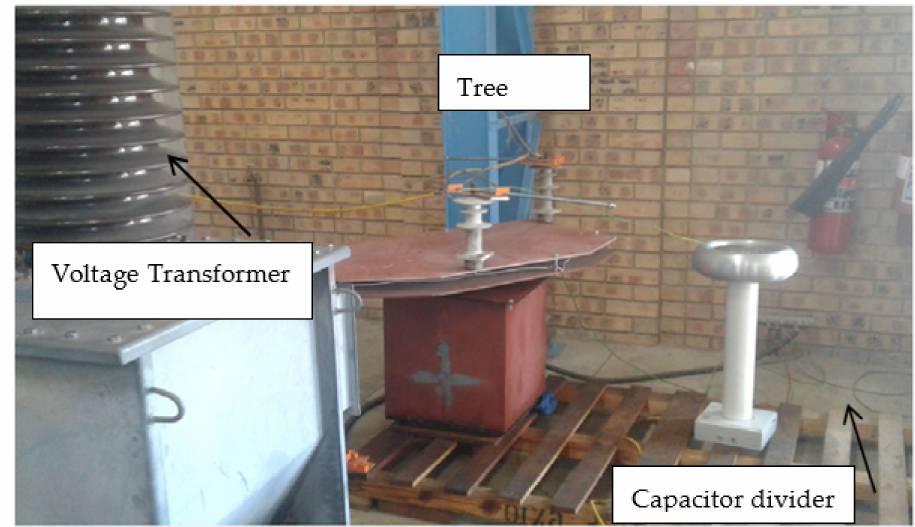
Figure 8. HIF experimental setup.